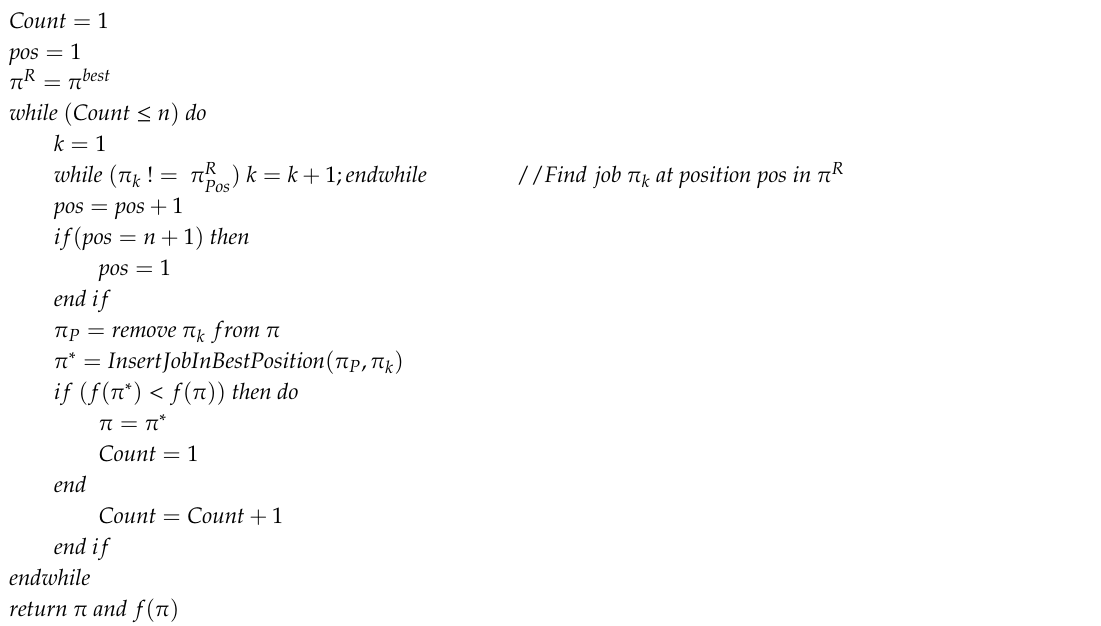
Algorithm 7: Referenced insertion neighborhood( π )